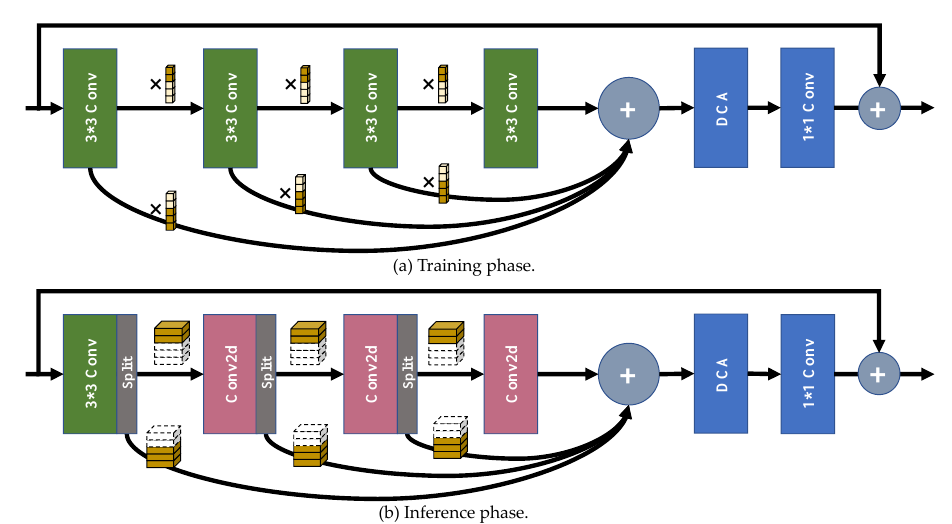
Figure 5. The sketch map of the selective channel processing module (SCPM). ( a ) is the flow path of feature maps in the training phase, while ( b ) is the flow path of feature maps in the inference phase. The combination of the small cubes in ( a ) denotes the channel selection matrix. The cuboids in the box denotes the feature maps generated by the previous convolution layer in ( b ). The activate layers are not shown for simplicity.